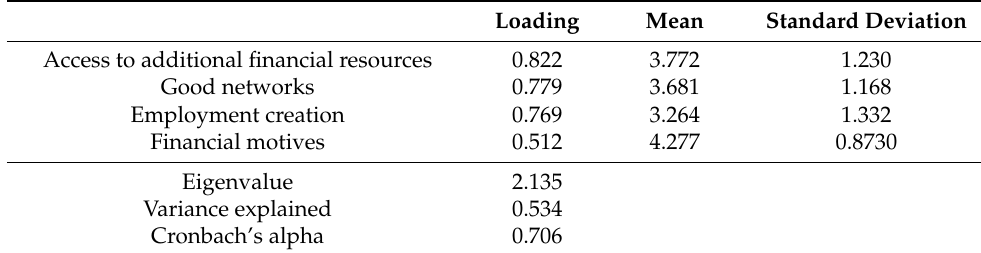
Table 2. Component matrix: motivation for